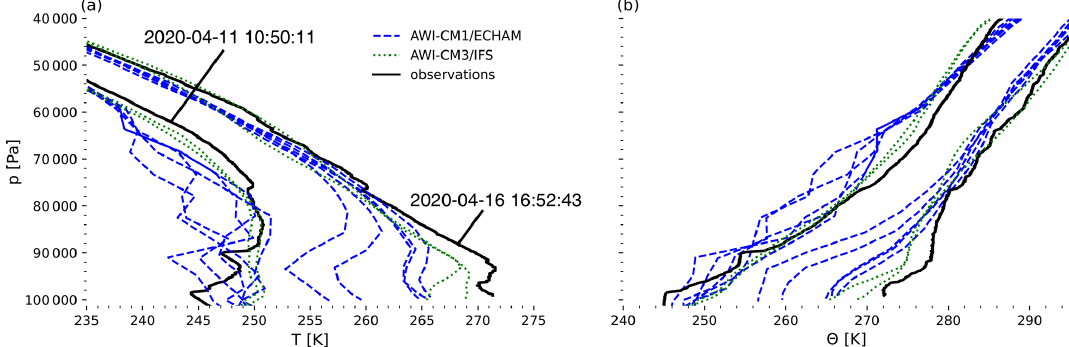
Figure 9. Modelled and observed (a) temperature and (b) potential temperature profiles at the MOSAiC site before (11 April 2020, 10:50:11UTC) and during (16 April 2020, 16:52:43UTC) the moist intrusion. High-frequency model-level output was only saved for two